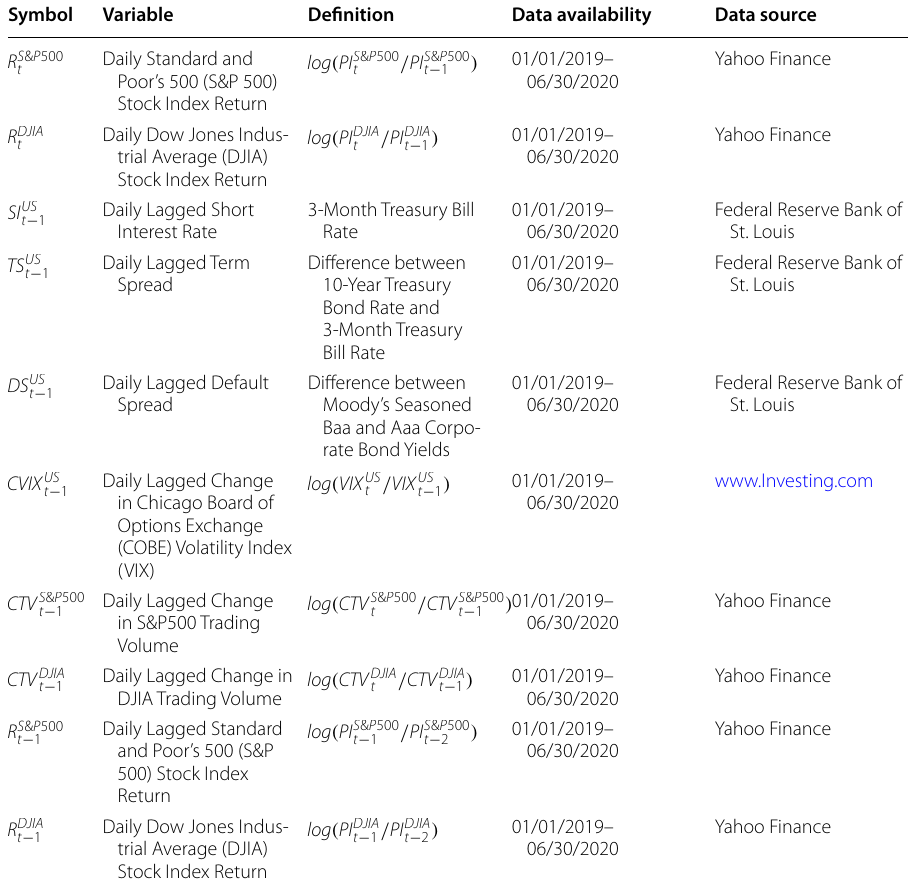
Table 1 shows primary information for both stock index returns and predictor variables. PI = the stock price index adjusted for both dividends and splits; VIX = volatility index. Subscripts t and t − 1 are day t and t − 1 , respectively